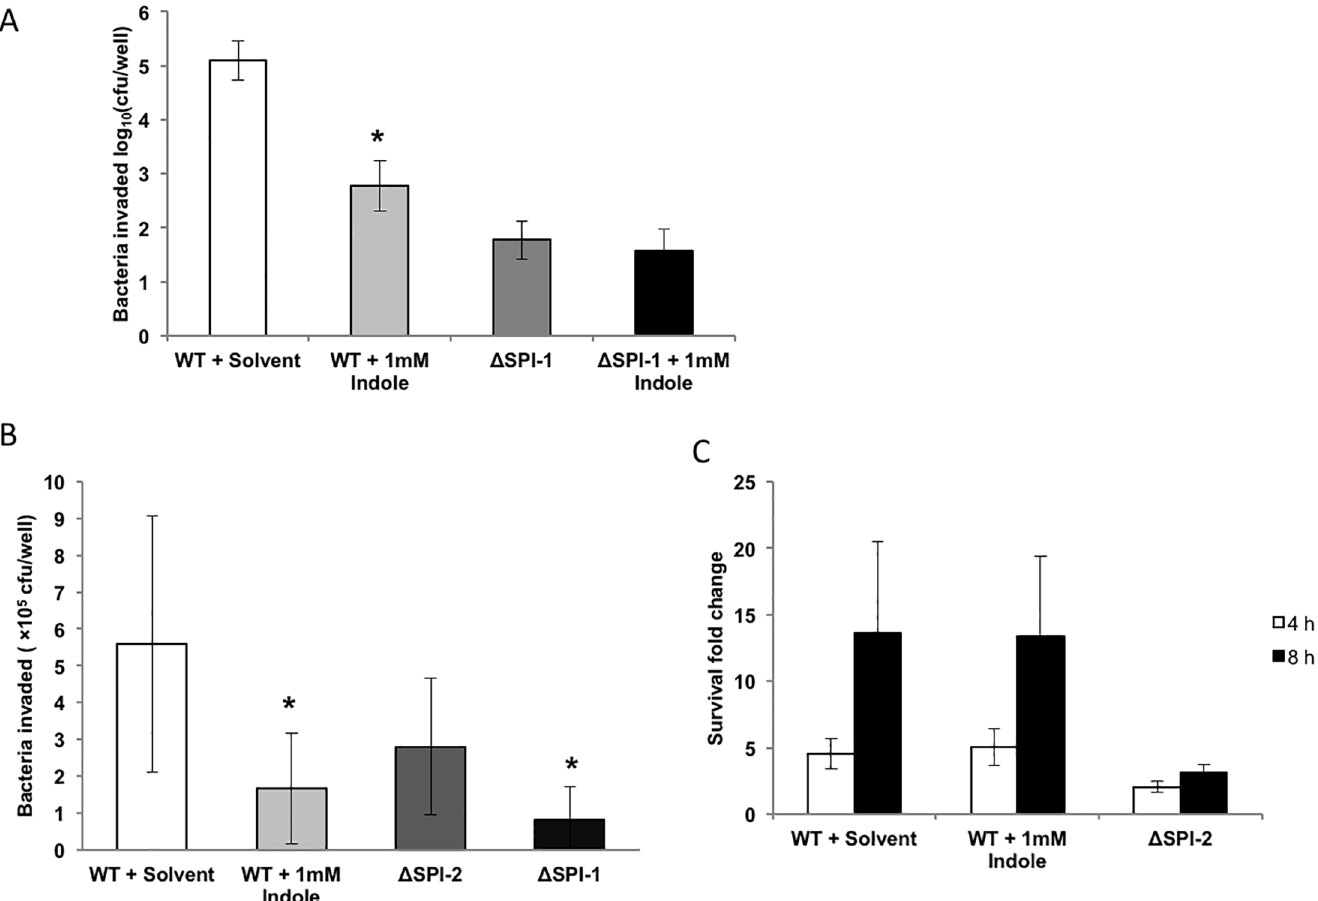
Fig 3. Invasion of epithelial cells and invasion and intracellular survival within macrophages with indole-treated Salmonella . Invasion in HeLa epithelial cell line (A) with Salmonella treated with or without 1mM indole. Invasion (B) and intracellular survival (C) in J774A.1 cells. Infection with the Δ SPI-1 and Δ SPI-2 strains were used as controls. A MOI of 50:1 was used for HeLa cells and a MOI of 10:1 was used for J774A.1 macrophages. Data shown are intracellular bacteria recovered and fold changes in survival (at 4 and 8 h post invasion) relative to the invasion. (cid:3) denotes statistical significance relative to the solvent control at p < 0.05 using the Student’s t - test. Column bars depict mean (n = 3) and error bars represent standard deviation (SD).